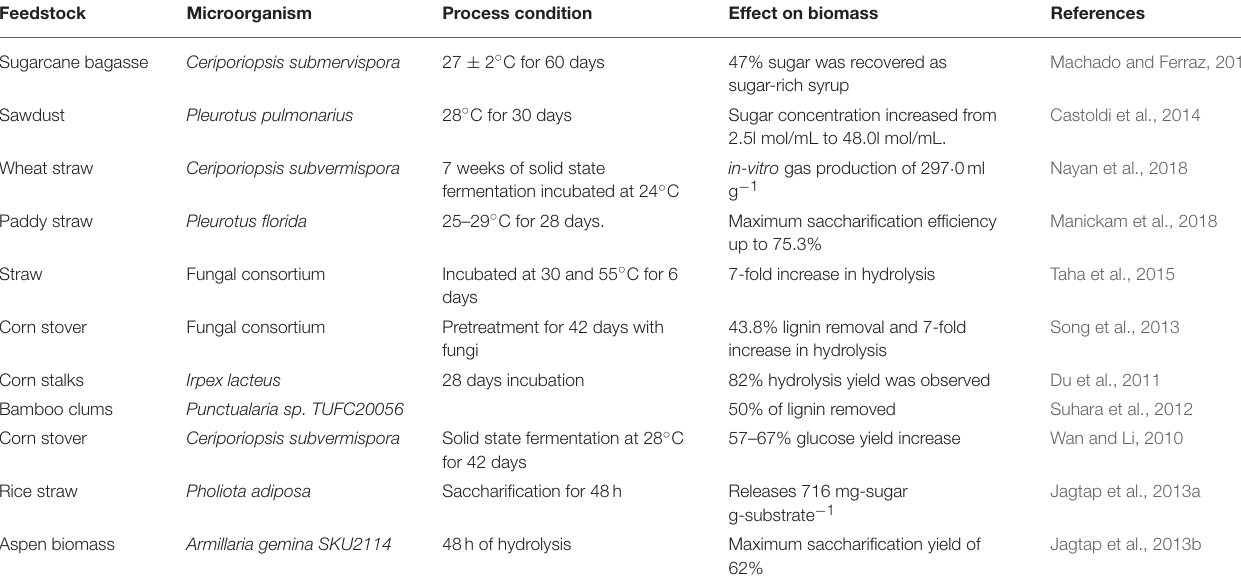
TABLE 3 | Biological pretreatment conditions for various feedstocks.